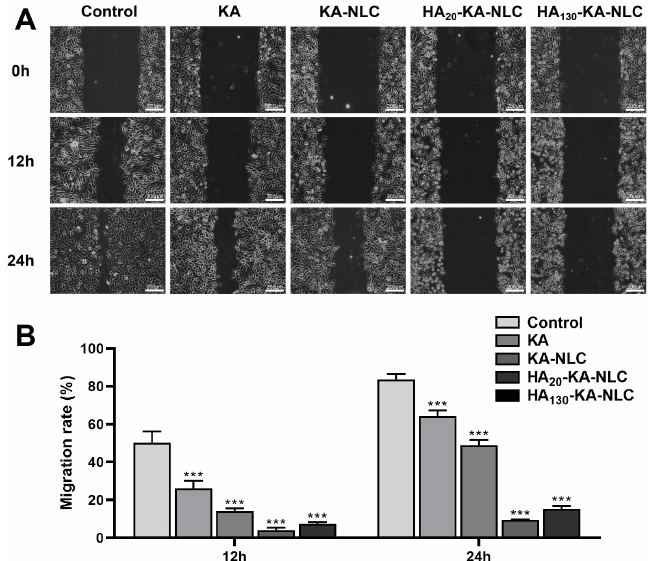
KA-NLC, and HA 130 -KA-NLC treatments. ( A ) Representative images of wound healing assays. ( B ) Migration rate of cells after different treatments. The data are presented as the mean ± SD ( n = 3). *** p <